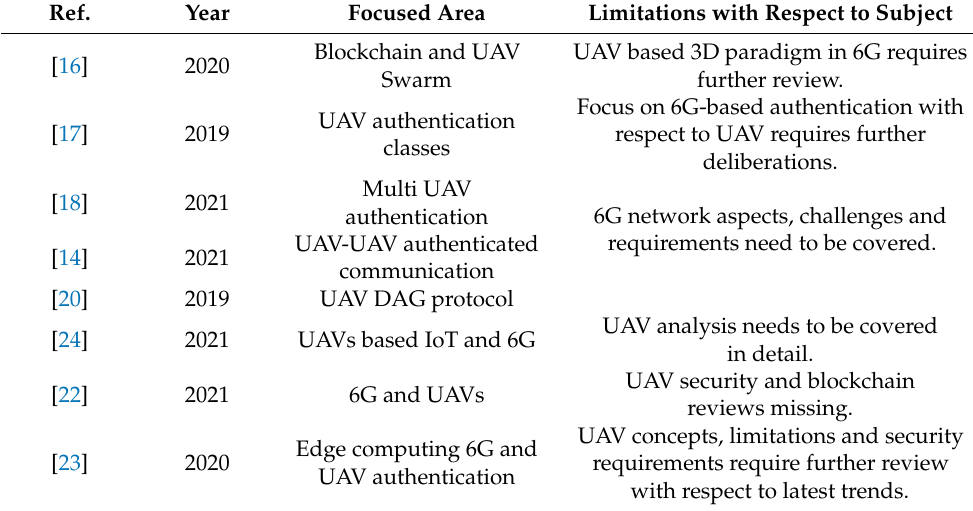
Table 1. Previous studies and